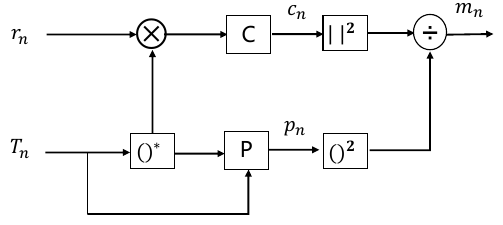
Figure 11. Cross-correlation algorithm.